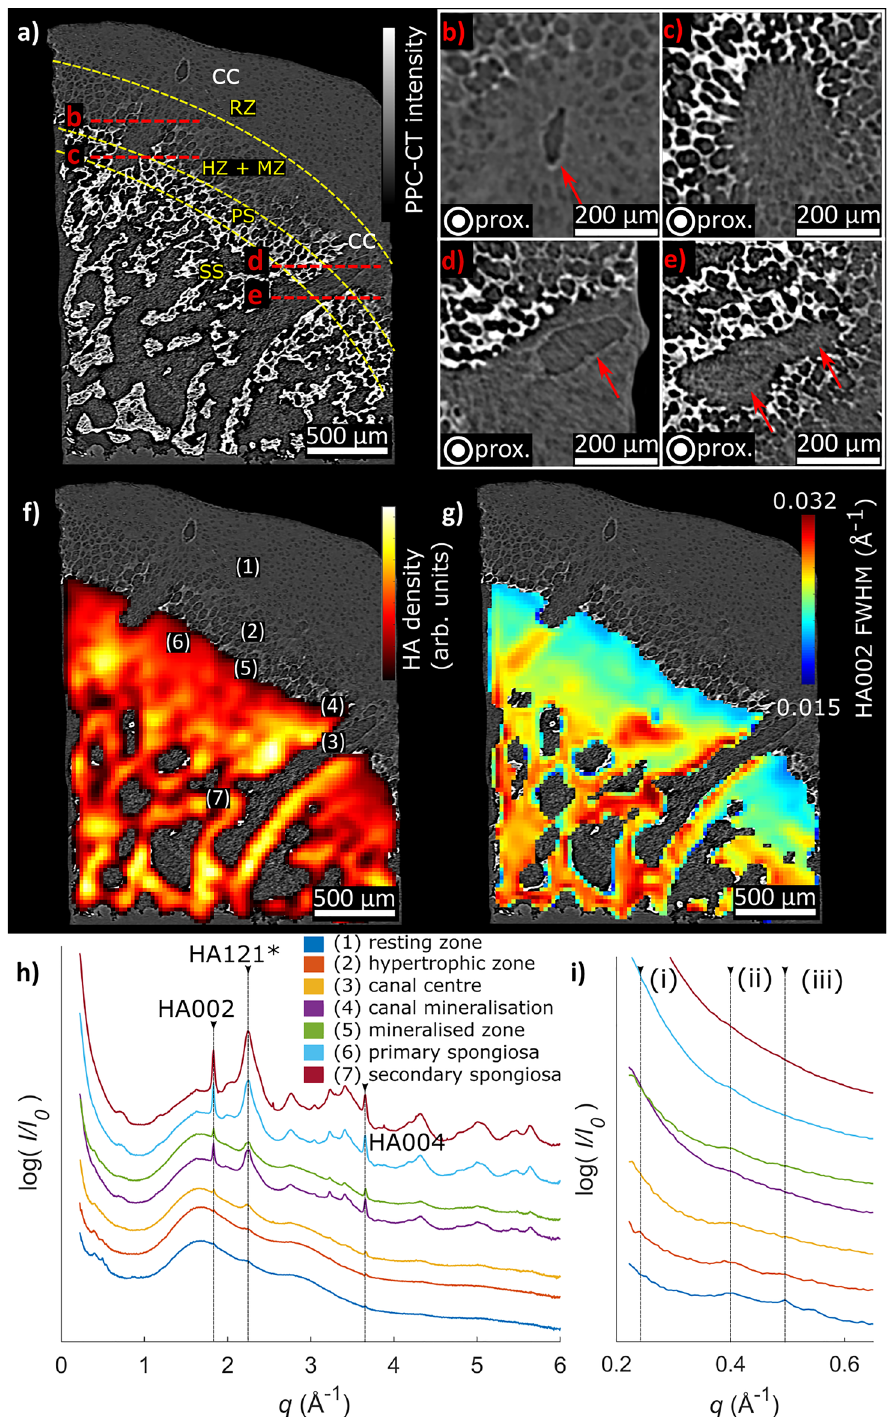
Figure 2. Cross-sectional view of the sample, showing the bone morphology in a region where two cartilage canals (cc) protrude into the bone. (a) 2D PPC-CT cross-section, with distinct zones in cartilage and bone delineated with yellow dashed curves. The red dashed lines give the location of the orthogonal (out of plane) magnified sections shown in (b–e) . RZ resting zone, HZ hypertrophic zone, MZ mineralized zone, PS primary spongiosa, SS secondary spongiosa, cc cartilage canal, prox. proximal. (b–e) Magnified out-of-plane oriented cross-sections corresponding to the red dashed lines in (a) . The red arrows indicate cartilage canal walls. (f) XRD-CT cross-section of the local HA density, overlaid with the PPC-CT cross-section from (a) . (g) Spatial variations of the HA002 peak width, showing that the peak width decreases towards the ossification front. The XRD-CT cross-sections in (f,g) have been up sampled by a factor 2 for display purposes. (h) XRD-CT reconstructed 1D diffractograms for the regions marked with (1)–(7) in (f) , demonstrating that HA is observed in all mineralized regions. Small Bragg peaks are observed in the resting zone and hypertrophic zone of the cartilage around q = 0.5 Å −1 . An intensity offset has been added for display purposes. ( i ) Magnified view of the low q scattering used for SAXS analysis. Weak collagen SAXS peaks indicated with (i, ii, iii) are associated with collagen interfibrillar